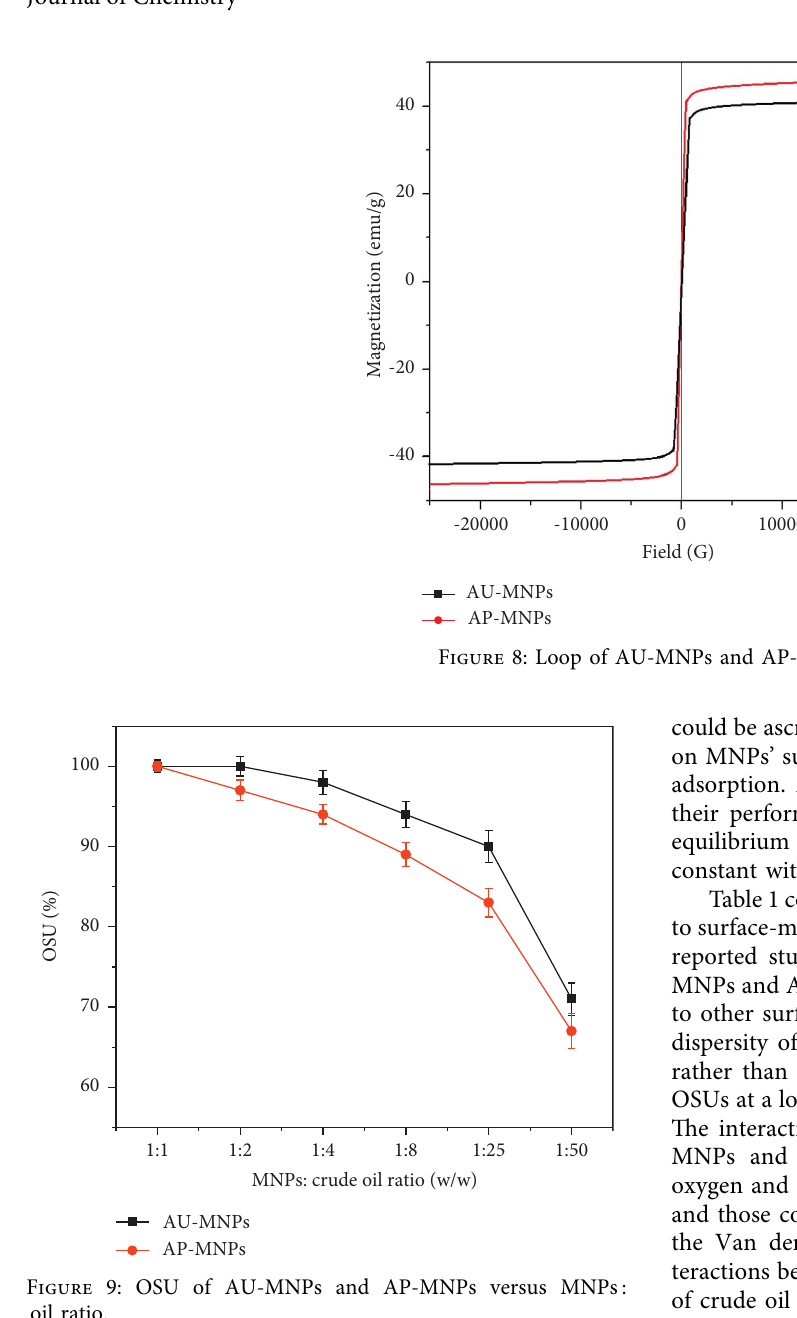
a MNPs : oil ratio of 1 : 4, as shown in Figure 11. Te data show that as the contact time increased, the OSU of AU- MNPs and AP-MNPs increased to 10 min, reaching 98% and 94%, respectively. An increase in the OSU at the beginning